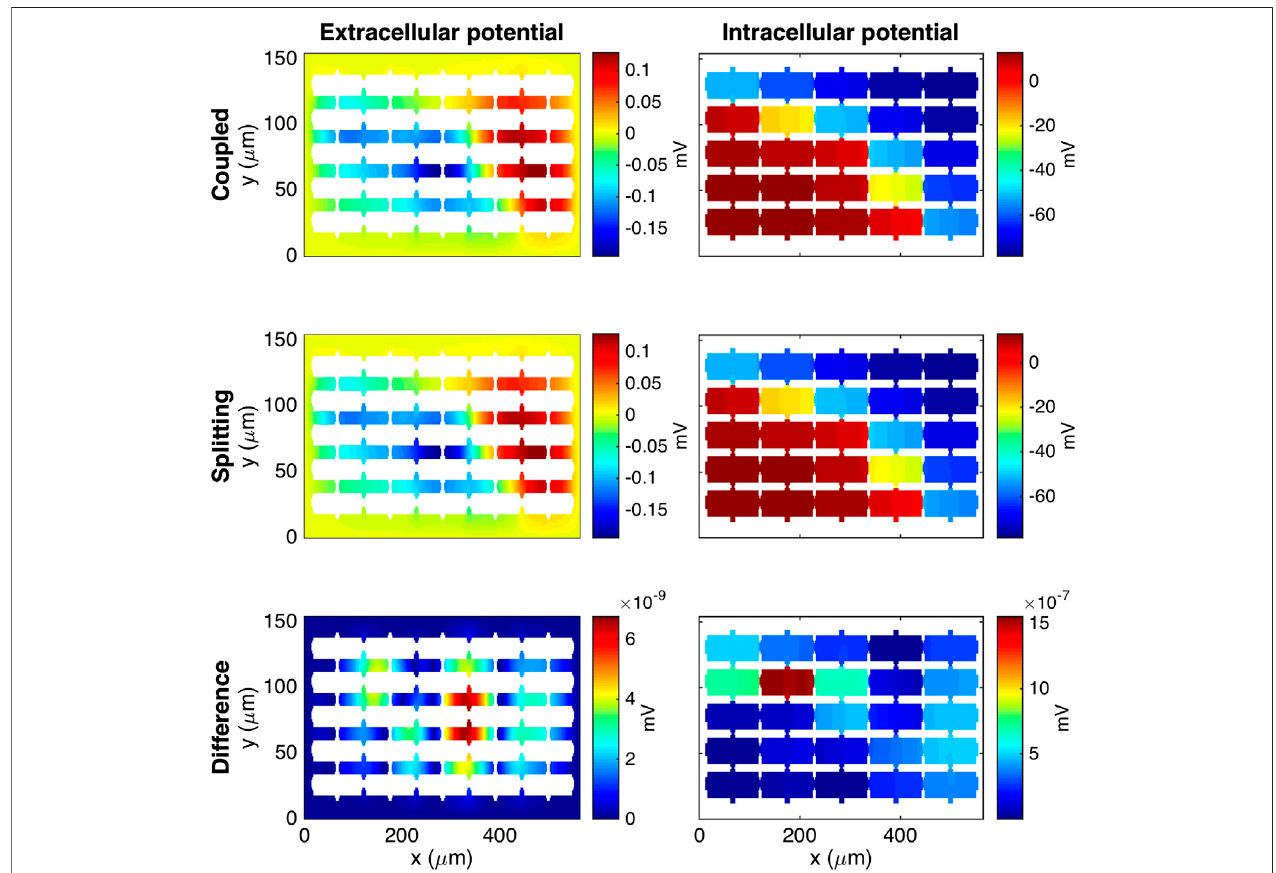
FIGURE 9 | Comparison of the solutions of the coupled (C) and splitting (S) approaches for the EMI model for connected cells. The left panel shows u e and the right panelshows u i .Furthermore,theupperpanelshowsthesolutionoftheCapproach,themiddlepanelshowsthesolutionoftheSapproach,and thelower panelshowsthe absolutevalueofthedifferencebetweenthetwosolutions.Thesolutionsarecollectedat t (cid:2) 2 . 5 ms,andtheplotsshowthesolutionsinasheetinthecenterofthedomainin the z -direction. The parameters used in the simulations are speci fi ed in Tables 1 and 3 , and we use fi ve inner and outer iterations in the S approach ( M it (cid:2) N it (cid:2) 5 ) .